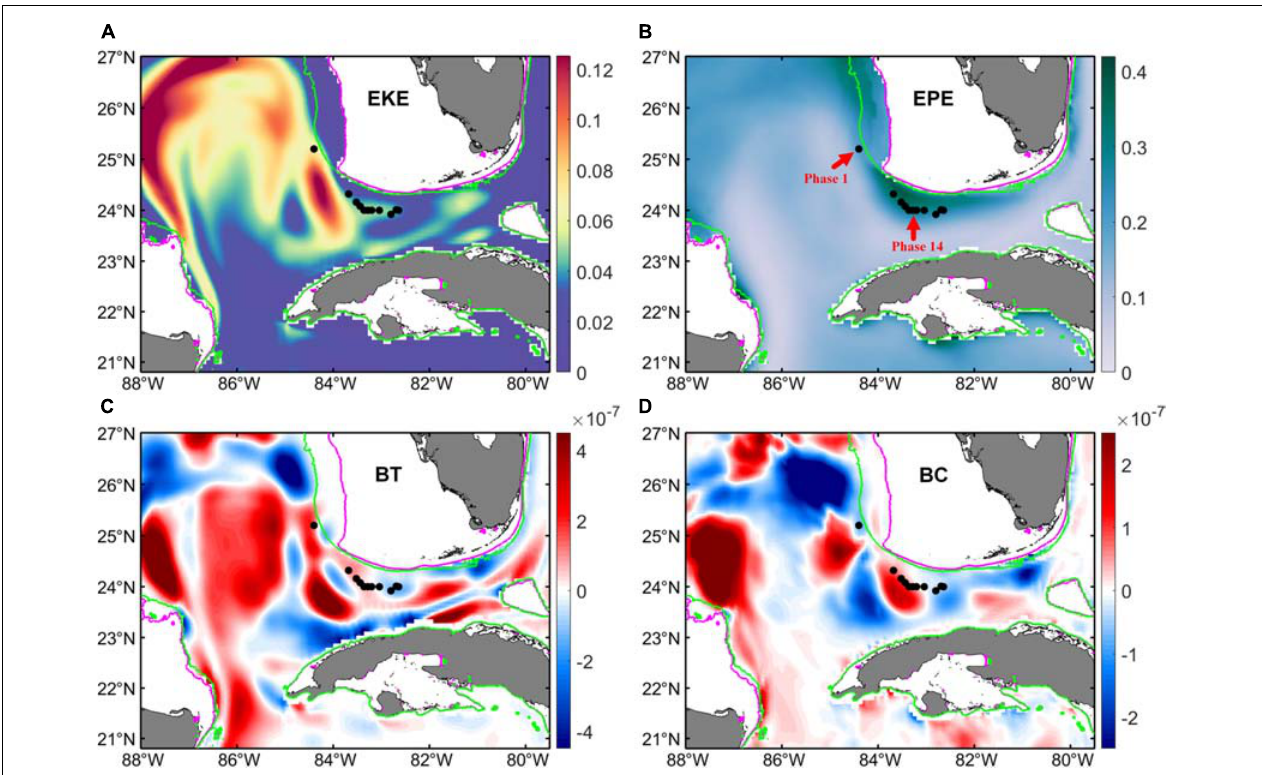
FIGURE 10 | Horizontal distributions of mean (A) EKE (unit: m 2 /s 2 ), (B) EPE (unit: m 2 /s 2 ), (C) BT (unit: m 2 /s 3 ), and (D) BC (unit: m 2 /s 3 ) from April 9th to August 12th, 2017. These variables are vertically averaged from 0 to 800 m. The black dots on each map denote the eddy centers determined from weekly mean global HYCOM surface current fields during phases 1–14 ( Figure 5 , April 9 to July 15, 2017), and they are the same as those shown in Figure 6B . The eddy centers during phases 1 and 14 are annotated with red arrows in (B) . Calculations are shown for depths greater than 100 m; the 100 and 200 m isobaths are marked with magenta and green lines,